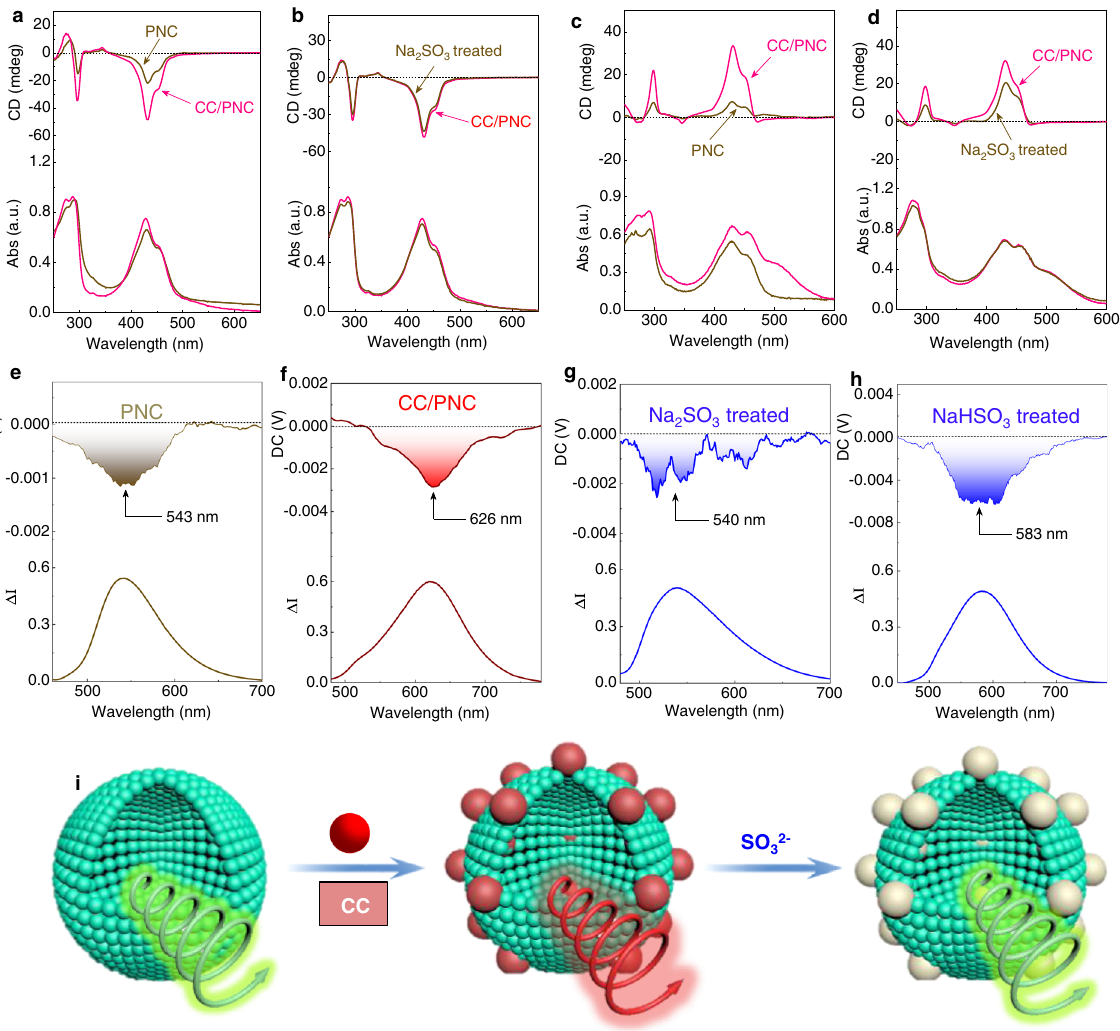
Fig. 6 In fl uence of coassembly and anions to CD and CPL spectra. Comparison of CD and corresponding UV – Vis absorption spectra of a PNC and PNC/ CC assemblies and b PNC/CC and PNC/CC/Na 2 SO 3 assemblies (THF/H 2 O = 1/9). Comparison of CD and corresponding UV – Vis absorption spectra of c PNC and PNC/CC assemblies and d PNC/CC and PNC/CC/NaHSO 3 assemblies (THF/H 2 O = 3/7). CPL spectra and corresponding fl uorescent emission of e PNC f PNC/CC g PNC/CC/Na 2 SO 3 h PNC/CC/NaHSO 3 ( fi lm). i Representation of CPL variation with different additives. Blue, red and gray particles represent PNC, CC and CC* respectively. ([PNC] = 10 − 4 M, [CC] = 10 − 5 M, [Na 2 SO 3 ] = 5 × 10 − 5 M, [NaHSO 3 ] = 5 × 10 − 5 M, THF/H 2 O = 1/9, excited at 430